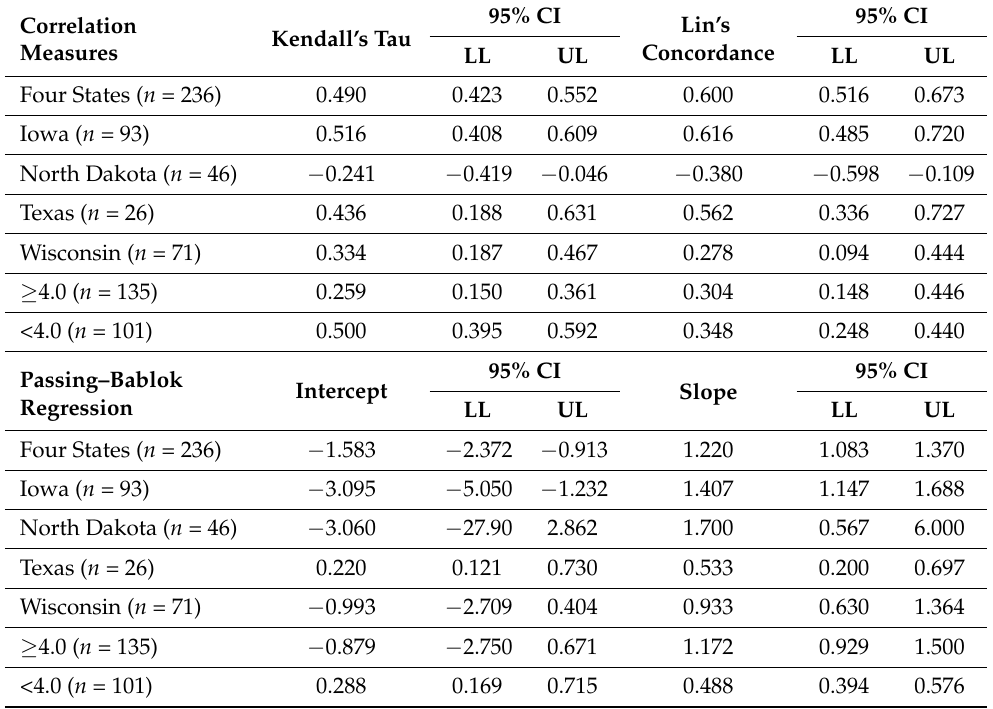
Table 1. Correspondence of Air Chek and EPA radon measures by state for 236